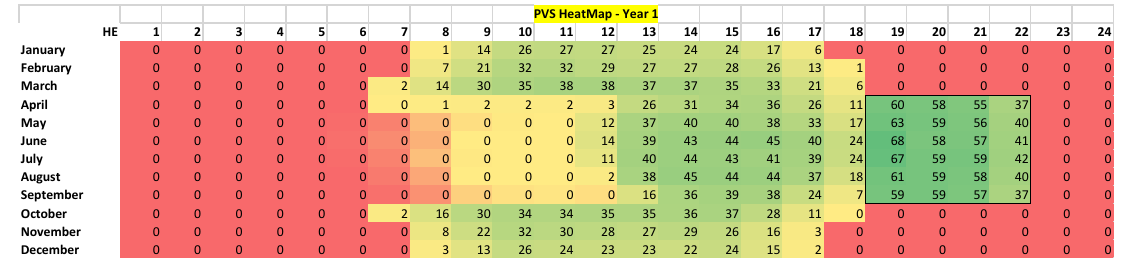
Figure 10. PVS Net Energy Delivered (MW DC ) Heat Map for the 50 MWac PV-60 MW / 240 MWh BESS system in Sonoma, CA for target period 6–10 p.m.